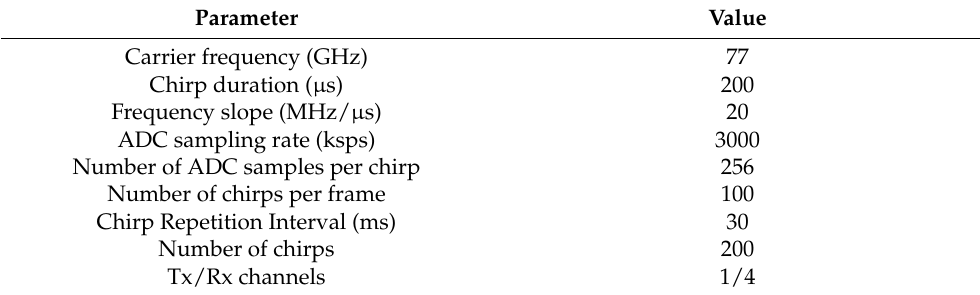
Table 2. Radar configuration parameters for gait